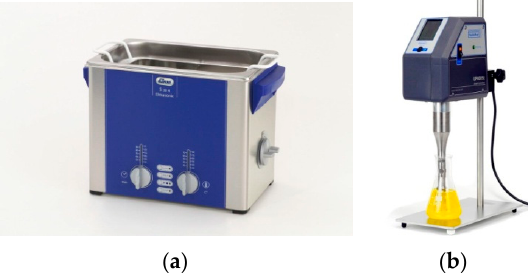
Figure 10. High-intensity ultrasound equipment. ( a ) Ultrasonic bath. ( b ) High-intensity ultrasound